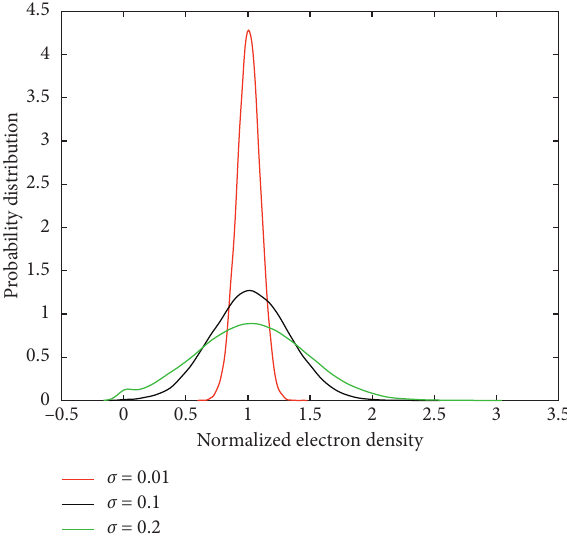
Figure 3: Normalized electron density under different “ σ